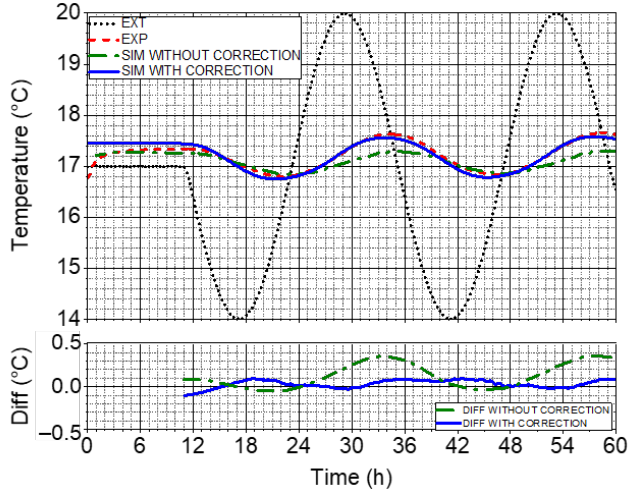
Figure 15. Mean air temperature within the building for the heavy house configuration.